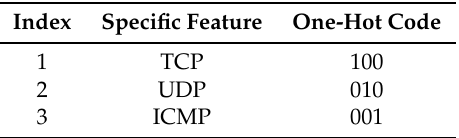
Table 7. Example of a one-hot code for the second feature (protocol